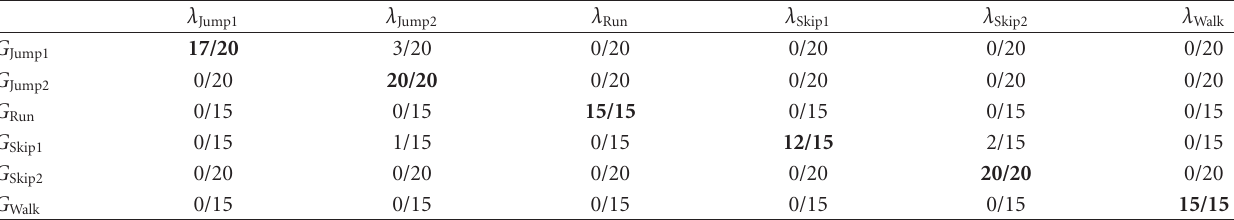
Table 1: Classification of human activities.